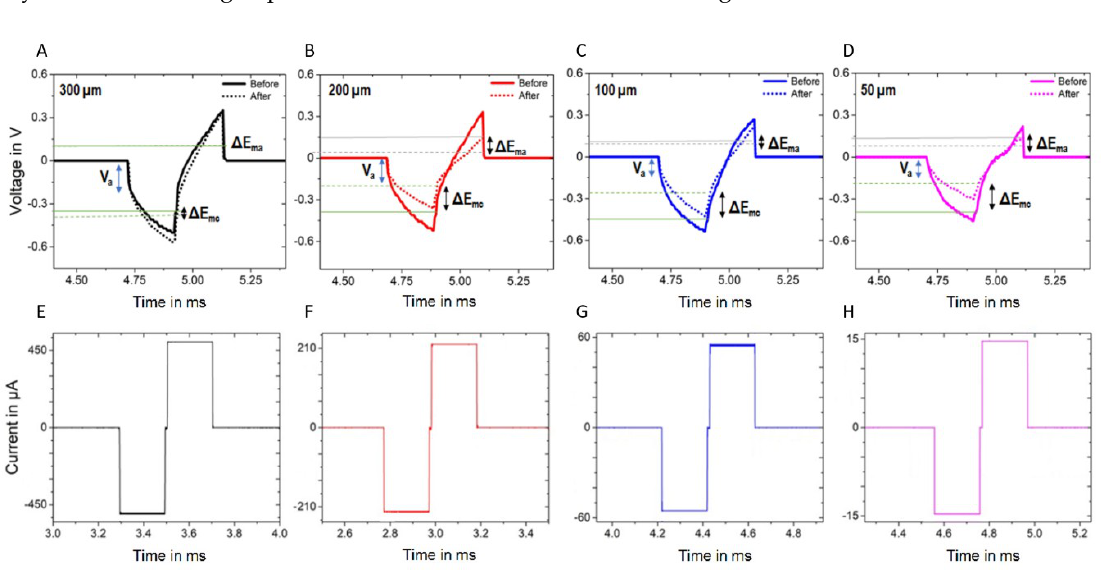
Figure 6. Voltage transient response of the four GC microelectrodes with diameters of 300 µ m ( A ), 200 µ m ( B ), 100 µ m ( C ) and 50 µ m ( D ), before and after stimulation (10 million pulses at 0.15 mC/cm 2 ). ( E – H ) show the protocols used for the biphasic pulse stimulation of the different diameter GC electrodes.